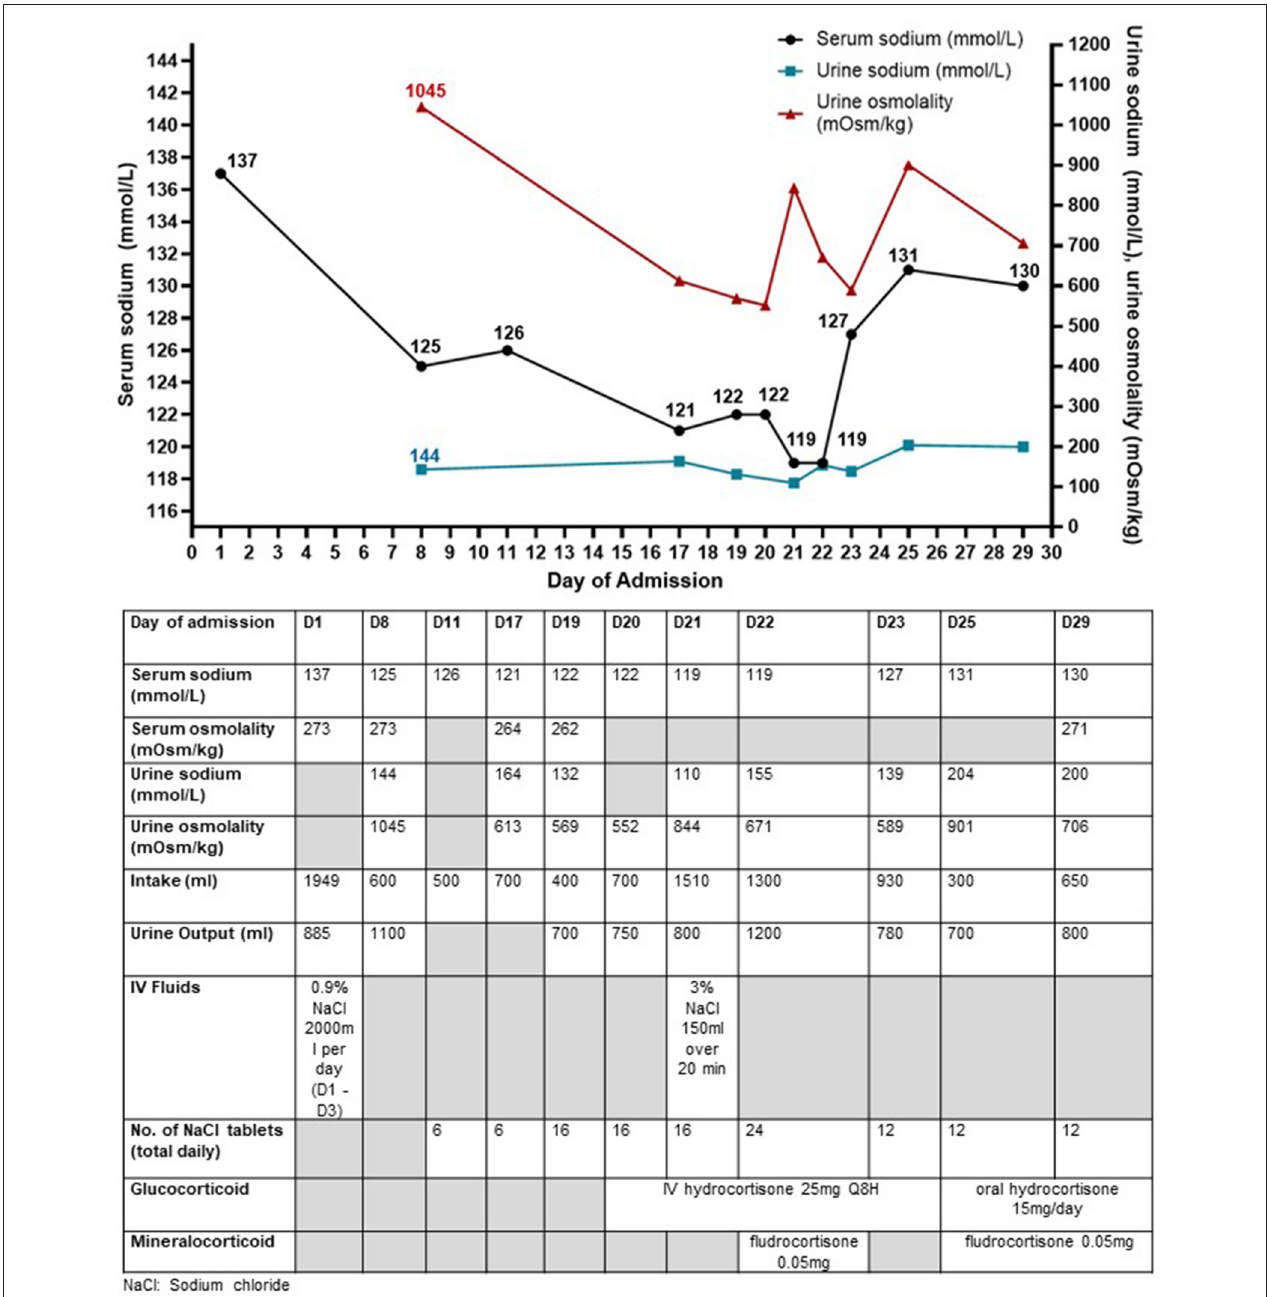
FIGURE 1 | Trend of serum sodium concentrations, urine sodium concentrations, and urine osmolality along with the interventions taken in Case 1 who presented with traumatic brain injury and later diagnosed with SIADH. The urine biochemistry was performed on urinary spot samples. The urine sodium concentrations were persistently raised ≥ 130 mmol/L throughout the hospital stay except on day